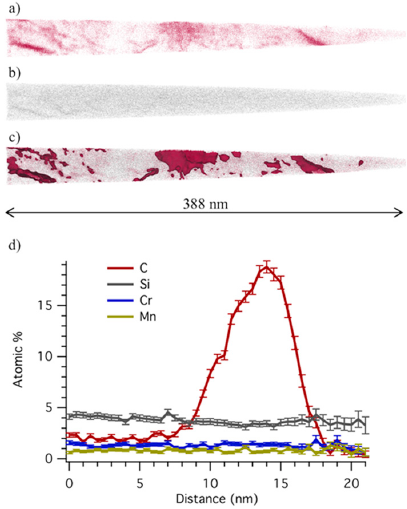
Figure 2. ( a ) Carbon and ( b ) silicon atom maps, ( c ) carbon isoconcentration surfaces at 5 wt.% C, and ( d ) proximity histogram across cementite plate in bainitic ferrite after transformation at 220 °C for 24 h in a high-carbon (0.7 wt.%) and high-silicon (1.5 wt.%) steel. In displacive reactions, the transformation product is restricted to the parent grain, and ferrite is formed with a crystal correspondence, in between the classic Kurdjumov-Sachs (K-S) and Nishiyama- Wassermann (N-W) orientation relationships. As the inverse-pole figure color map images in Figure 3 illustrate, low-temperature bainite exhibits the hierarchy ferritic sub-structure of blocks, i.e., aggregates of plates of ferrite of equal variant or variants slightly misoriented, and packets, i.e., adjacent blocks with a { 1 1 0 } ferrite plane almost parallel to the same { 1 1 1 } austenite plane, which is characteristic of lath martensite and bainitic ferrite in low-carbon steel [22–24]. The colors correspond to a crystal orientation, normal to the observed plane, representing different crystallographic variants. Here, a prior austenite grain encloses packets formed by three blocks with different orientations, and each block contains a single variant of ferrite.